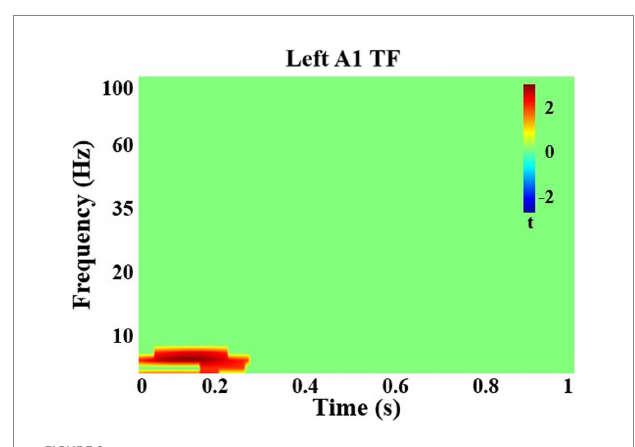
FIGURE 2 Time-frequency analysis in left primary auditory cortex. There was a significant increase in theta frequency power with attention in left auditory cortex from 0 to 330 ms in all